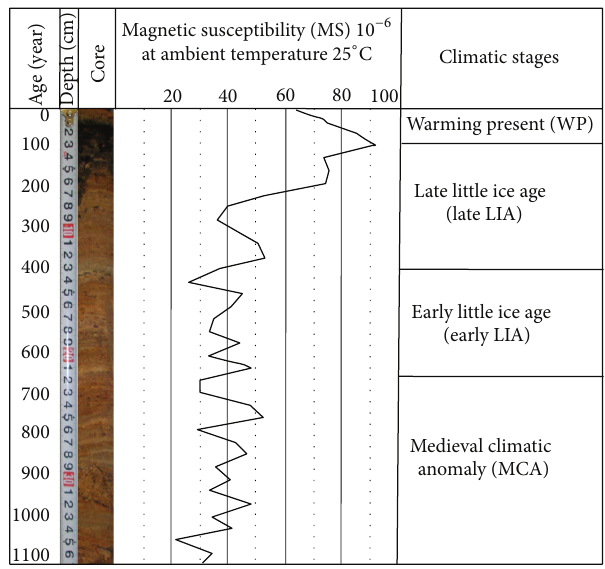
Figure2:Magneticvaluesattheambienttemperaturealongthecore from sebkha